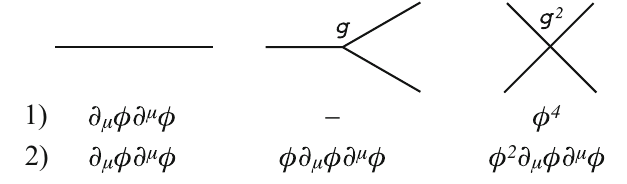
Fig. 1 Graphs used to construct the Lagrangians. The graph on the left corresponds to the free part of the theory yielding a 1 / r potential. The two other graphs create field self-interactions that distort this potential. In case (1), the forms of these terms are imposed by choosing a dimen- sionless coupling (no consistent cubic term can be formed). In case (2) they are chosen for a coupling of dimension [ energy ] −